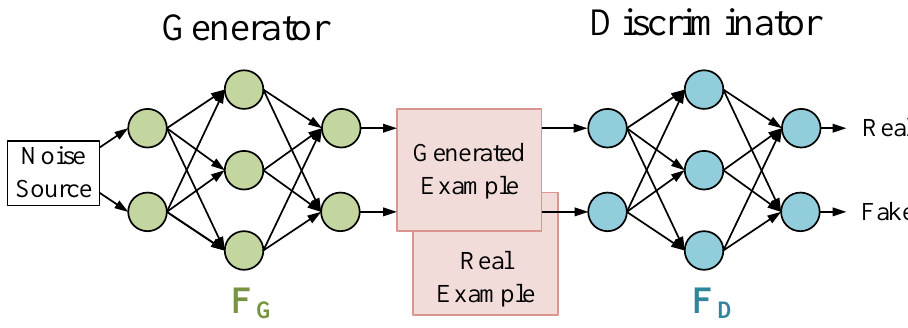
Figure 5. Typical structure of a GAN.